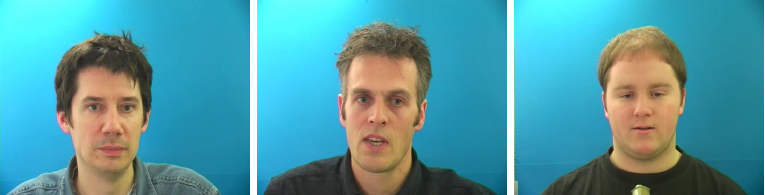
Figure 7. Still images from the GRID dataset. Figure 5. Random frames from the GRID dataset. Table 2. Sentence structure for the GRID